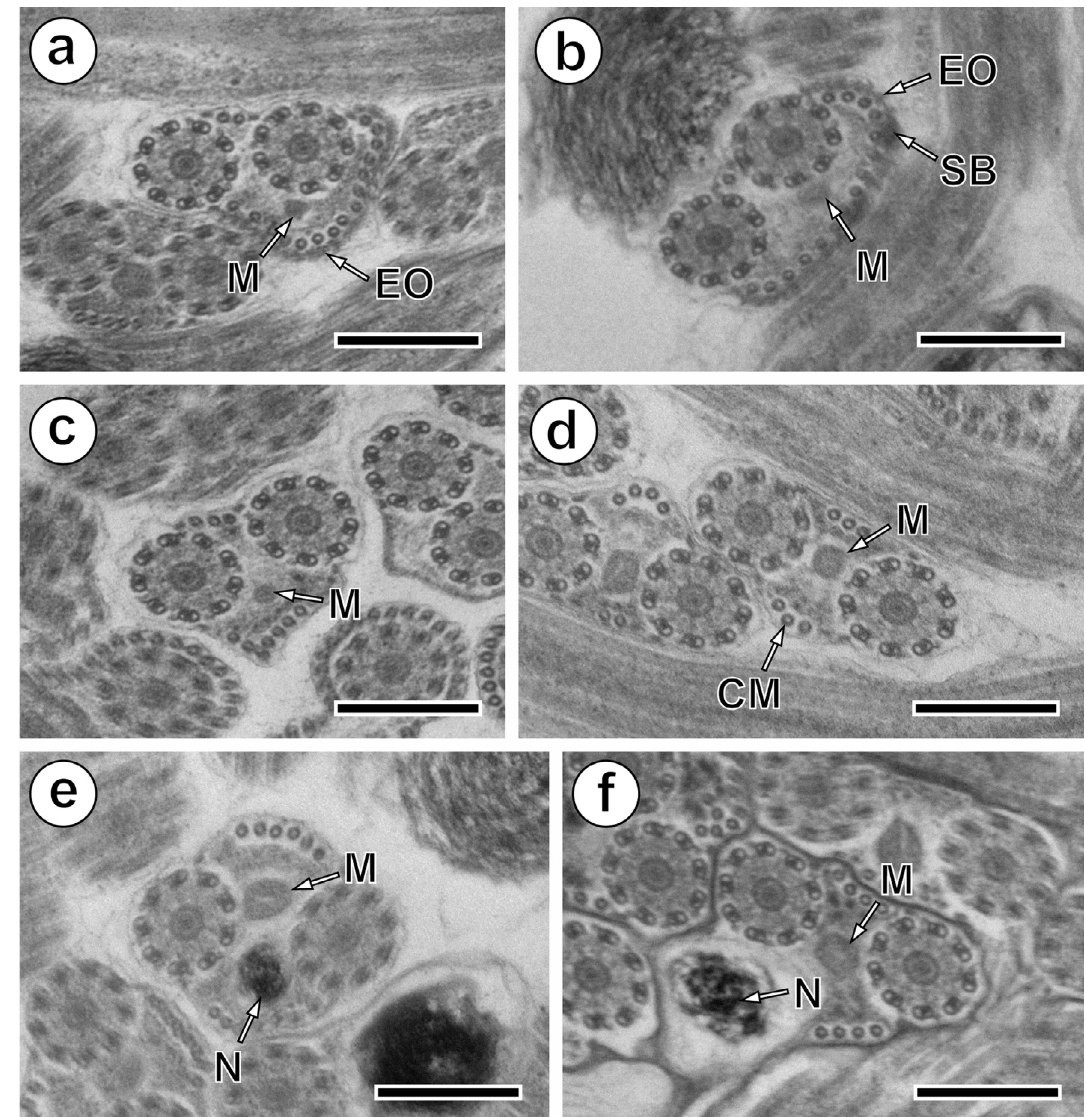
Figure 2. Mature spermatozoon of Collyricloides massanae . (a, b) Cross-sections in Region II or the ornamented zone of the mature spermatozoon exhibiting the mitochondrion (M), external ornamentation of the plasma membrane (EO) and spine-like body (SB). Note the association ‘‘external ornamentation + cortical microtubules’’. (c, d) Region III or transitional area before nuclear appearance, exhibiting in cross-sections, only both axonemes, mitochondrion (M) and few cortical microtubules (CM). (e, f) Cross-sections in the proximal part of Region IV, showing the nucleus (N) accompanied by mitochondrion and cortical microtubules. Note the increase in size of the nucleus and its eccentric position. Scale in l m: